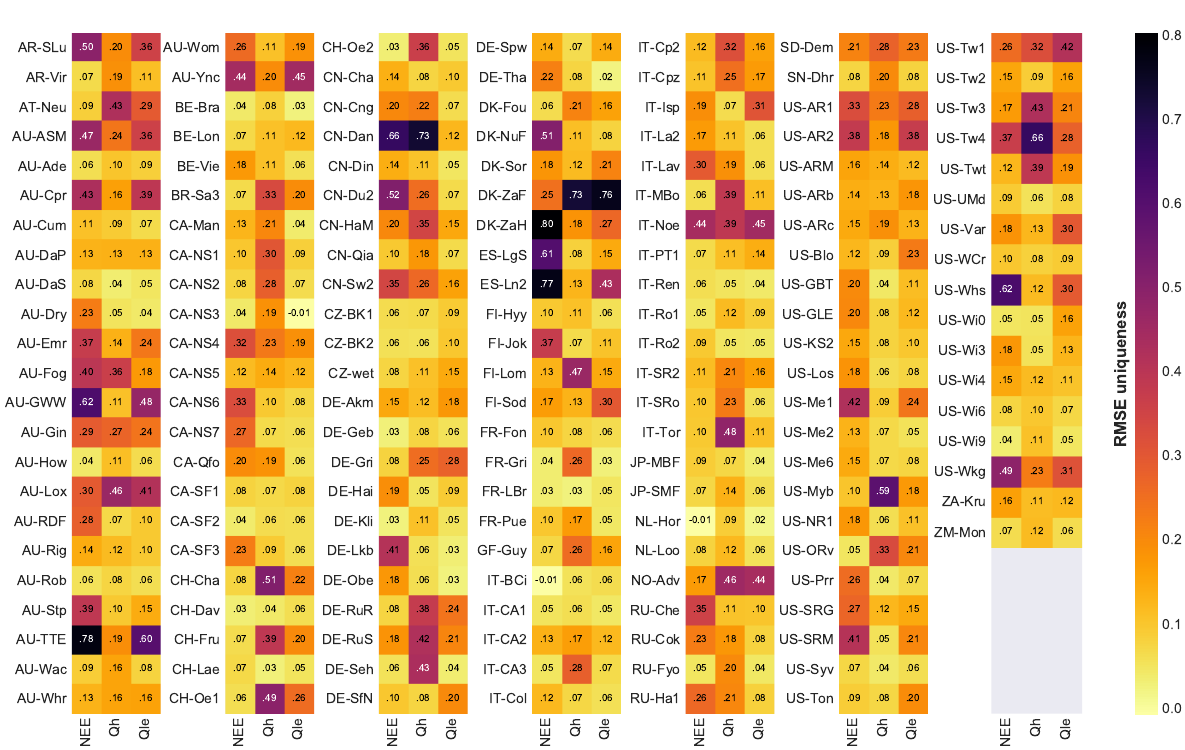
DE-Obe DE-RuR DE-RuS DE-Seh